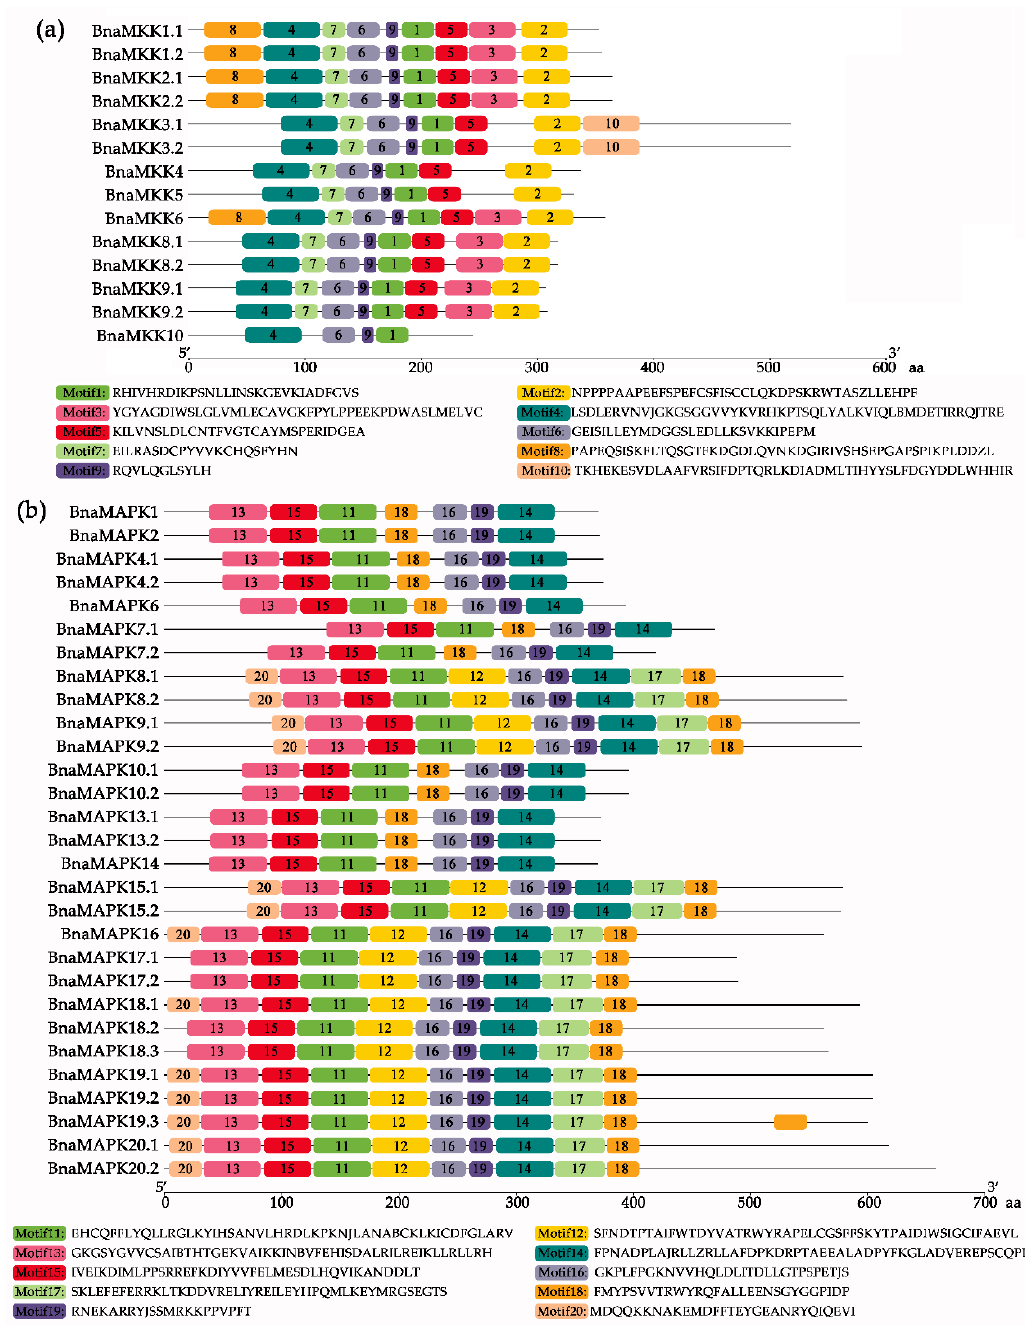
Figure 5. Distribution of conserved motifs in BnaMKK and BnaMAPK proteins. ( a ) Conserved motifs of BnaMKKs. ( b ) Conserved motifs of BnaMAPKs. Each motif is represented by rectangular boxes with different colors.